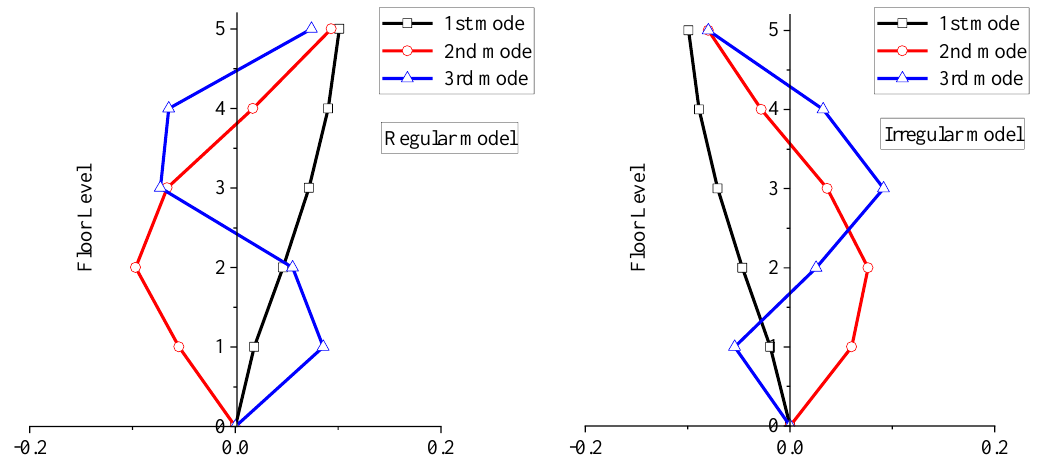
Figure 4. Mode shapes of regular and irregular building models. Table 4. Modal periods (seconds) of the two building models. Regular Model Irregular Model